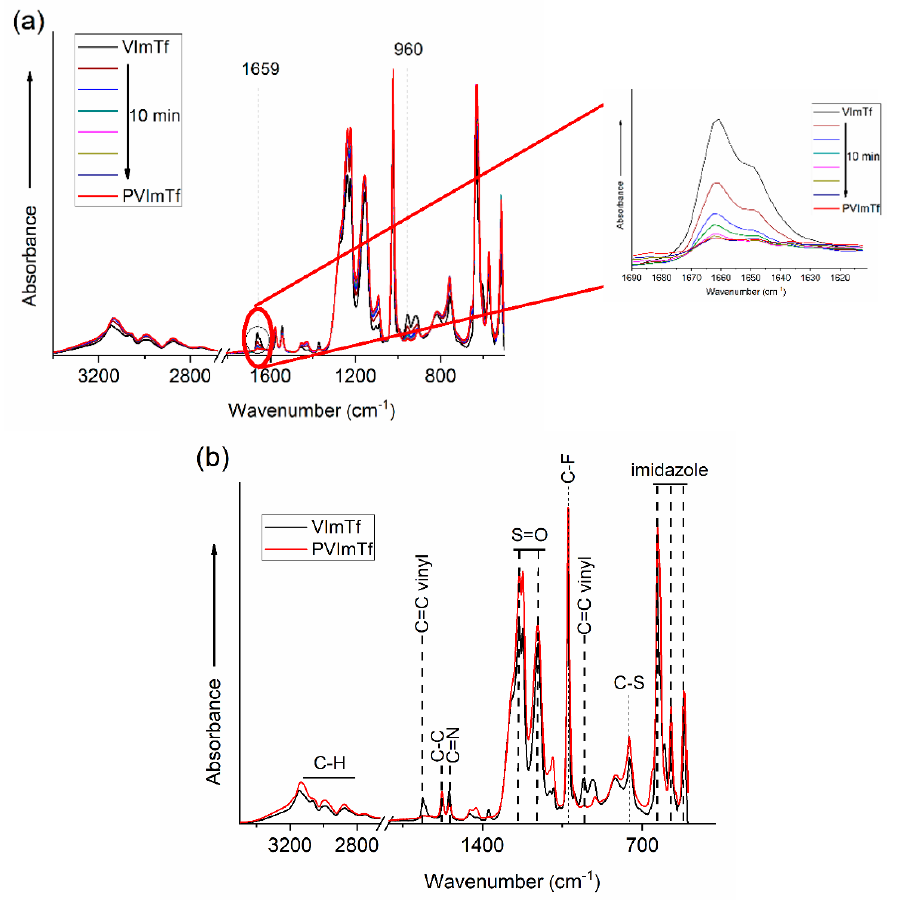
Figure 3. FTIR spectra of ( a ) VImTf and PVImTf and of ( b ) VImTf as a function of different polymer- ization